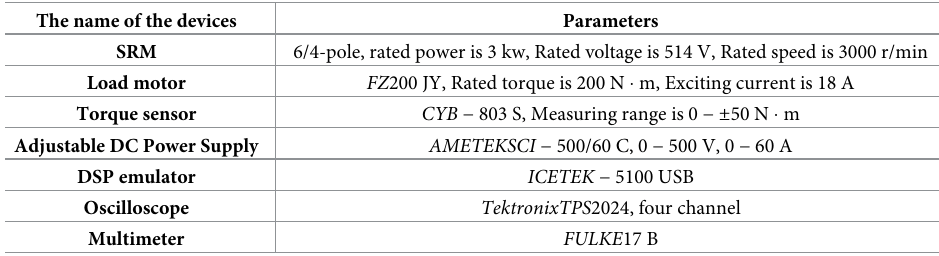
Table 12. Table of SRM experimental